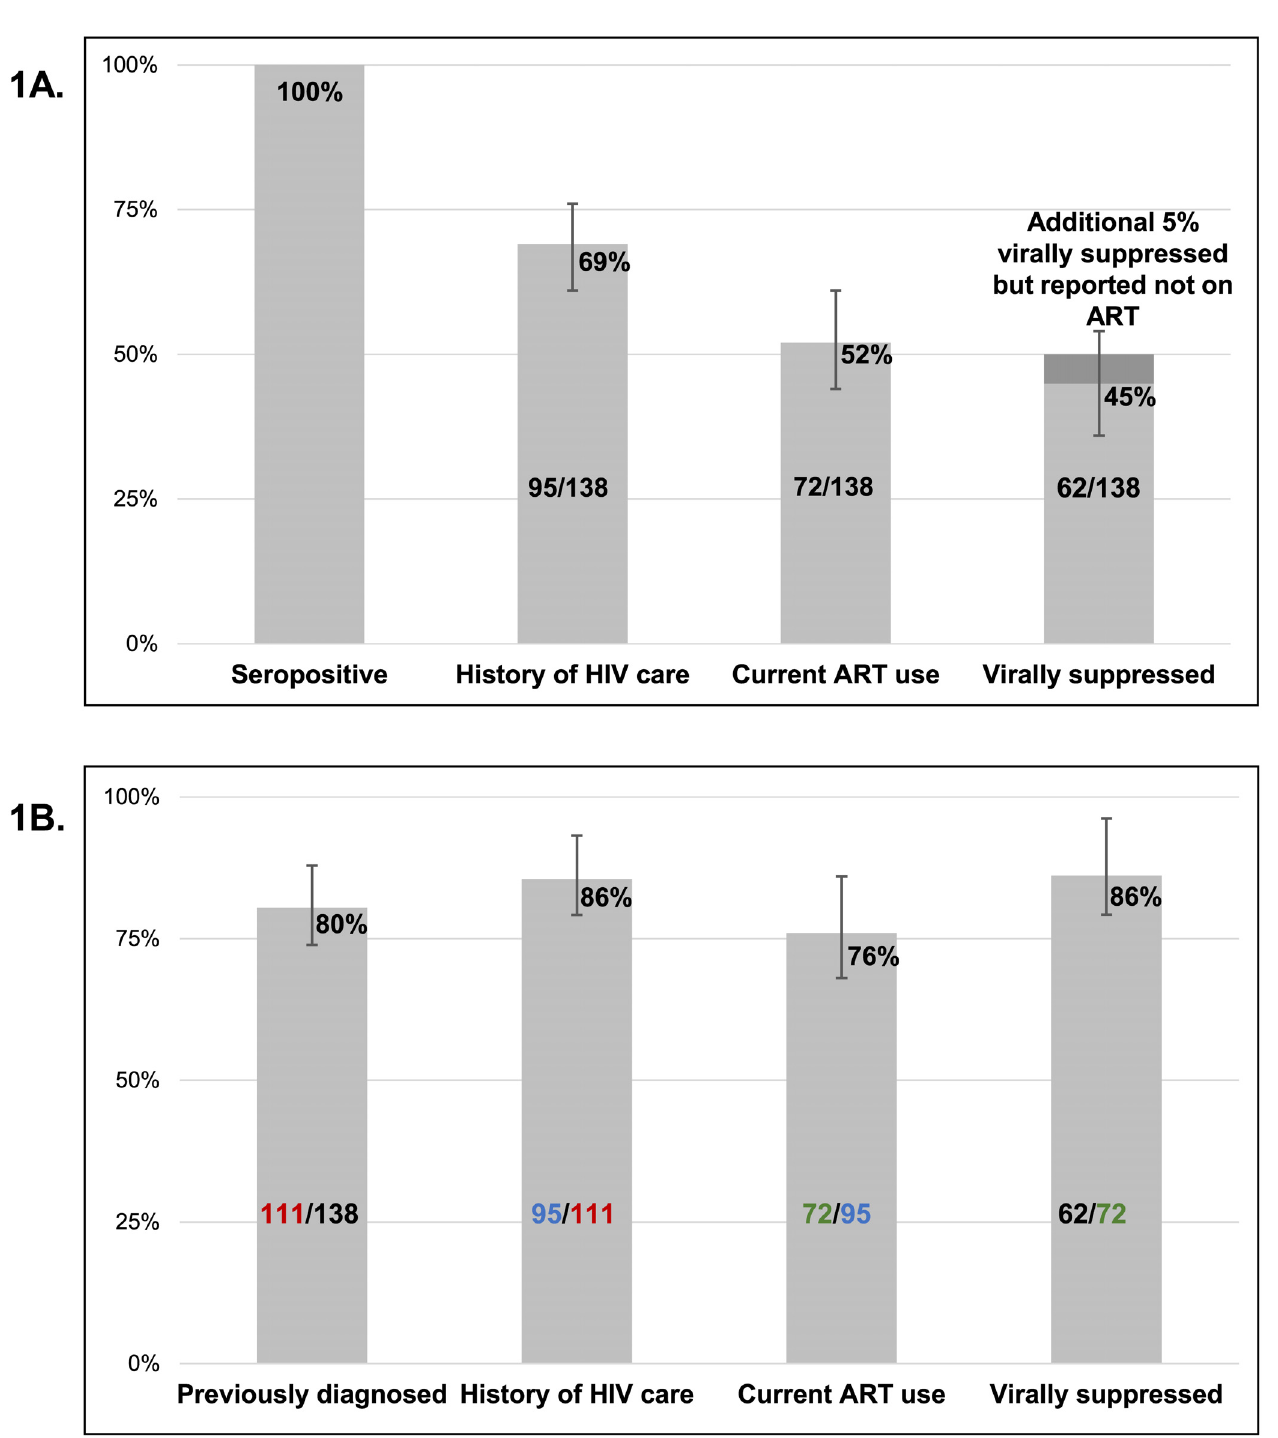
Fig 1. HIV Care Continuum among HIV-infected female sex workers, Lilongwe, Malawi (n = 138). 1A) Among all HIV-infected FSW; 1B) Among FSW achieving prior step. For Fig 1A, 69% (95/138) of all HIV-infected FSW had a history of care. Fifty-two percent (72/138) of all HIV-infected FSW reported current ART use and 45% (62/138) of all HIV-infected FSW were virally suppressed. For Fig 1B, 80% (111/138) of all HIV-infected FSW were previously diagnosed. While 86% (95/111) of FSW previously diagnosed had a history of HIV care. Seventy-six percent (72/95) of FSW with a history of HIV care reported current ART use. Eighty-six percent (62/72) of FSW reporting current ART use were virally suppressed.